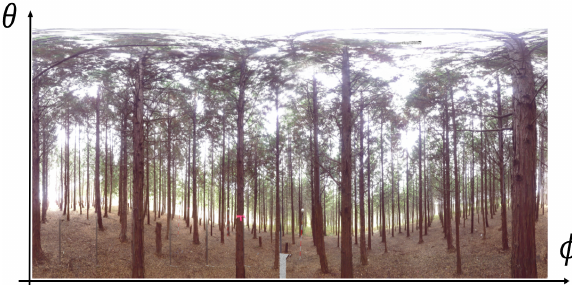
Figure 4. 2D Mapping of a point cloud